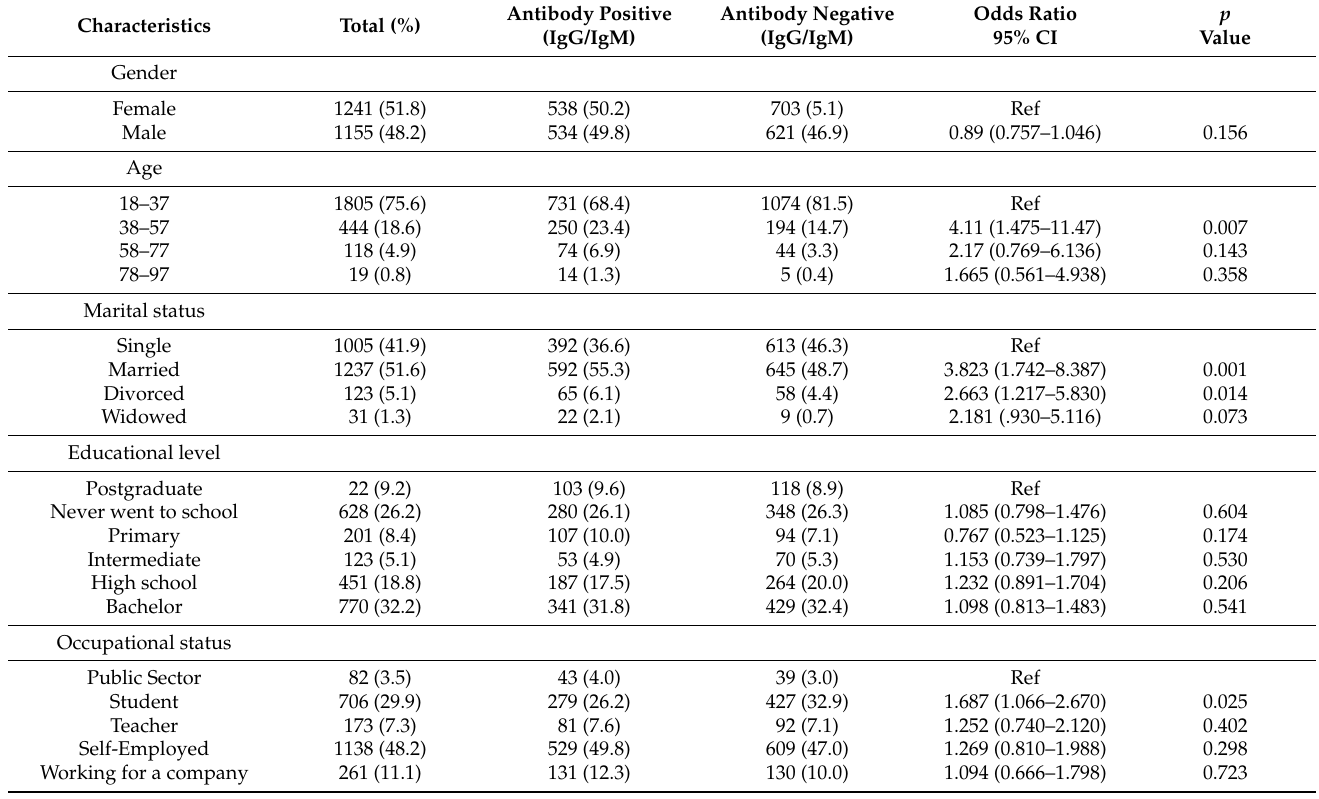
Table 1. Socio-demographic and COVID-19